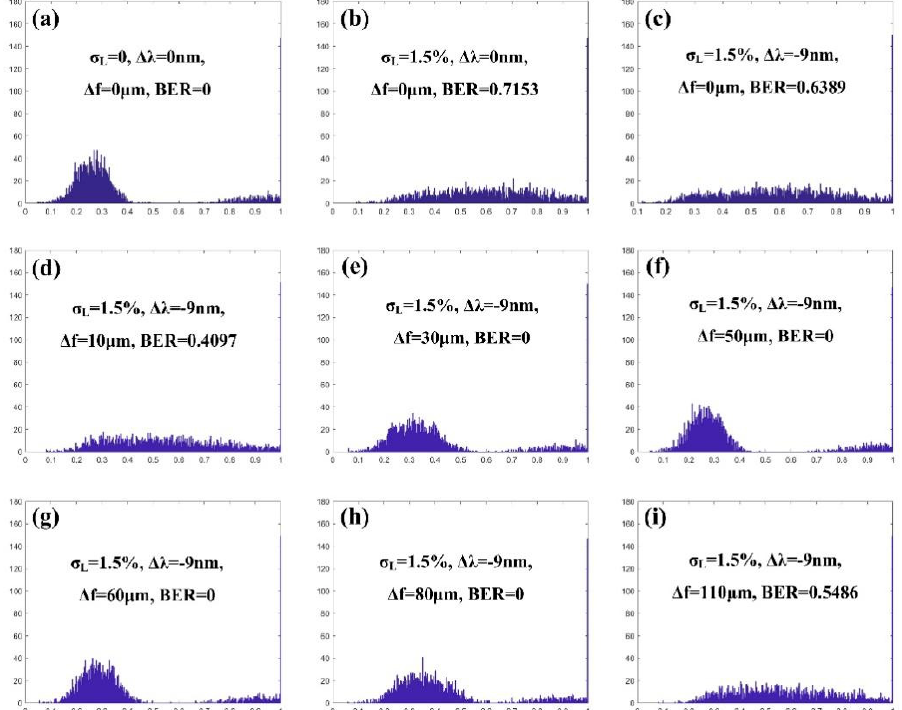
Figure 9. The normalized pixel distribution histograms of ( a ) the original reconstructed signal pattern; ( b ) the reconstructed signal pattern under σ L was 1.5% and without any compensation; the reconstructed signal patterns under σ L were 1.5% with the combination compensation method, in which the reading light wavelength was decreased by 9 nm and the focal length was changed by ( c )